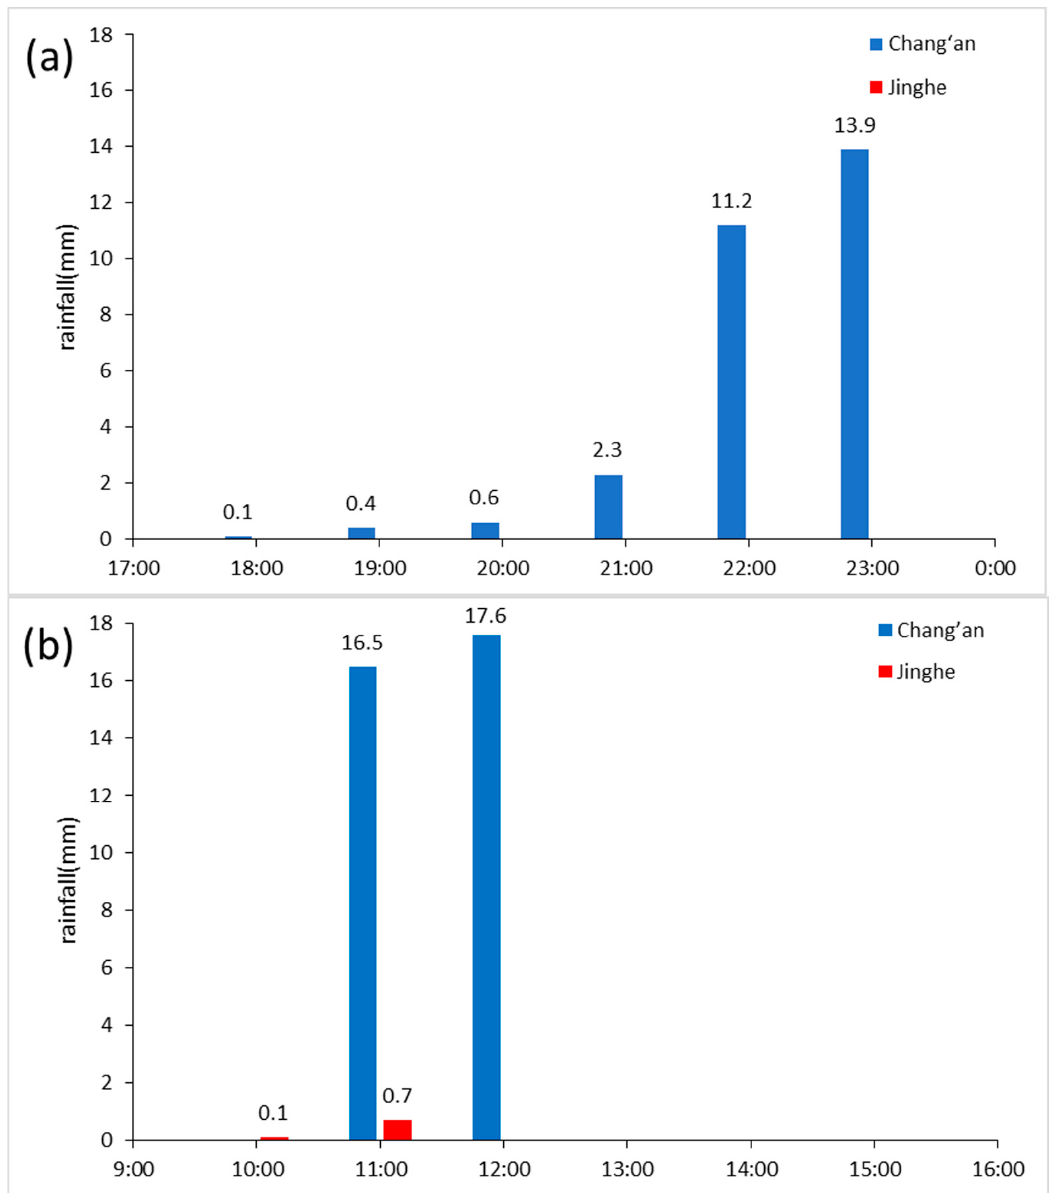
Figure 2. Hourly rainfall data of the Chang’an (blue) and Jinghe (red) meteorological stations during the hailfall process ( a ) and rainfall process ( b ).